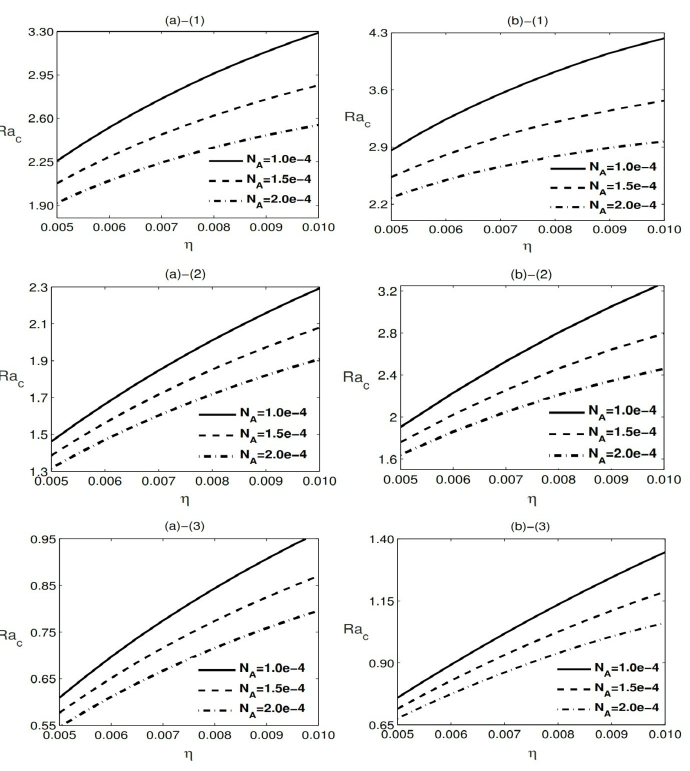
Figure 7: Variation of c Ra as a function of η for distinct values of A N for (a) 1 J = + and (b) 1 J = − ; for (1) I_C-I_C, (2) I_C-I_CHF, and (3) I_C-F_CHF